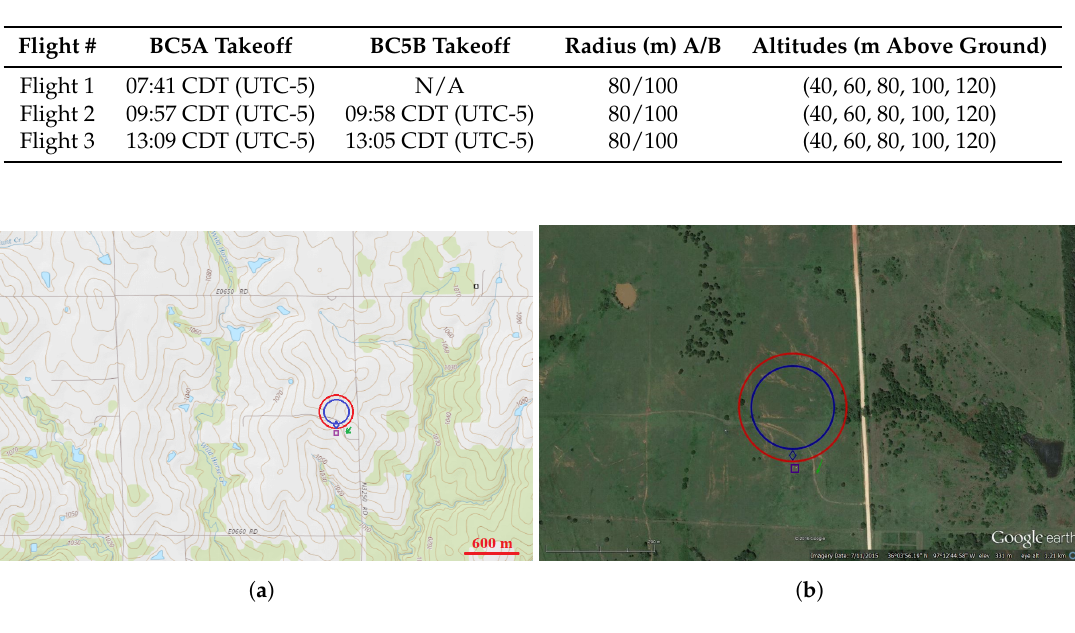
Table 3. Wednesday, 29 June 2016 flights overview.